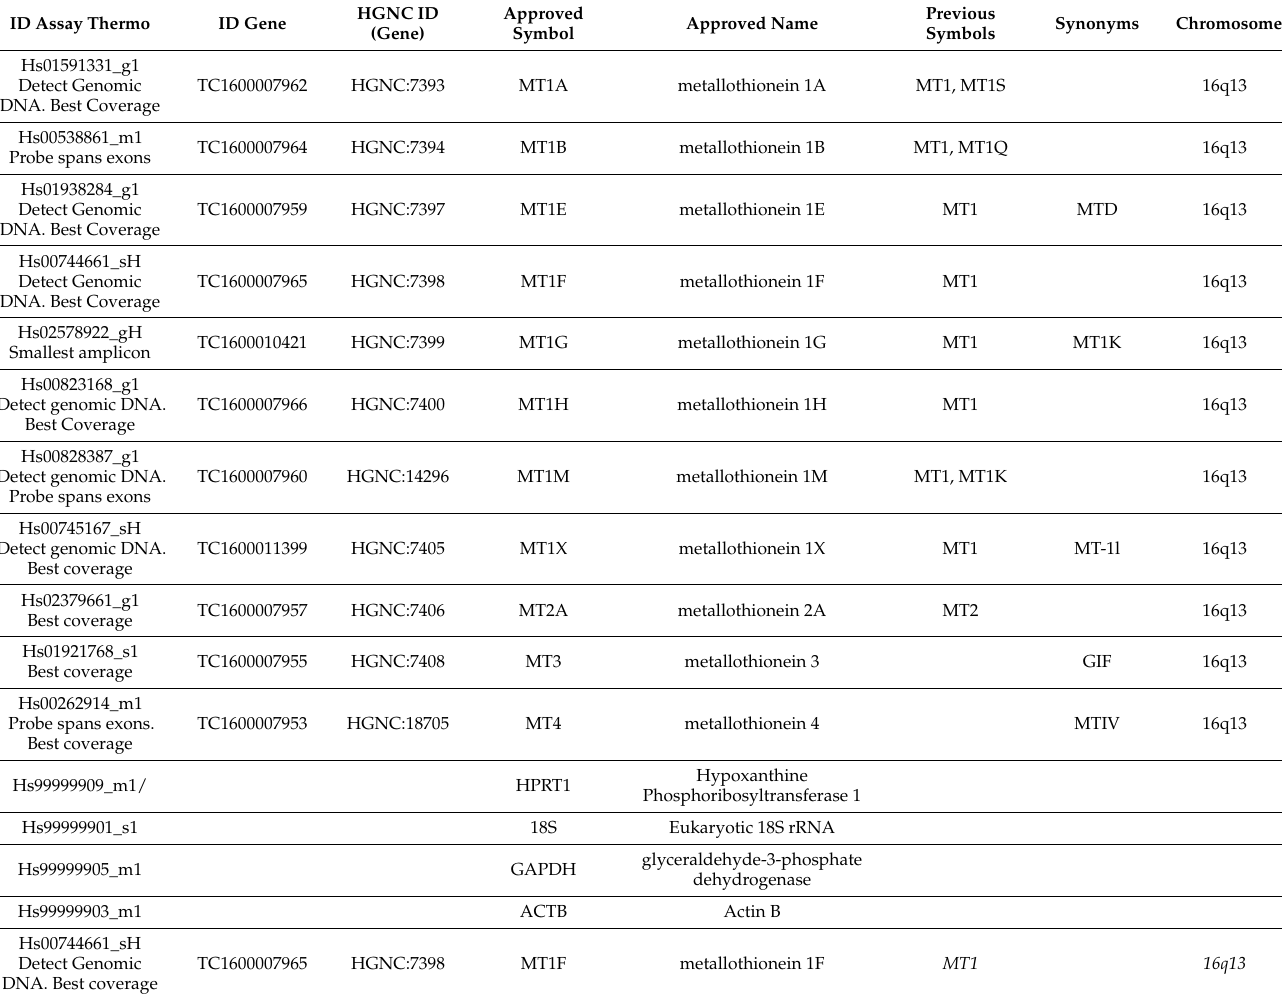
Table 2. Design of each plate with the genes to be studied and the controls. We worked with GAPDH, 18S, and HPRT1 because these are the endogenous genes that have been used in similar patients in other publications. Because there were two gaps left on the plate, we decided to introduce the endogenous B-Actin and repeat the MT1F to ensure that it was not